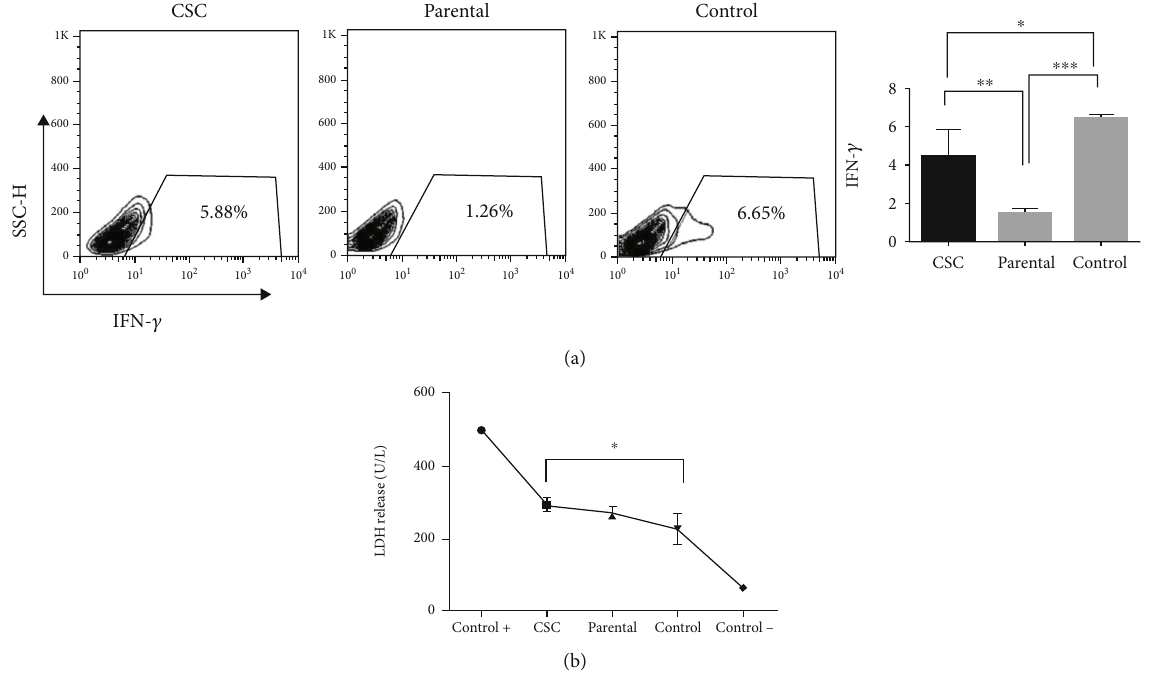
Figure 5: Cytotoxicity of T cells after exposure to gastrospheres and parental cell-derived conditioned media. (a) IFN- γ levels in PBMCs after exposure to gastrospheres or parental cell-derived conditioned media. (b) LDH release of MKN-45 cells (target) in culture with gastrospheres or parental conditioned media induced lymphocytes (e ff ector). CSC: gastrospheres. Data are mean ± SD of three independent experiments. ∗ P < 0 : 05 , ∗∗ P < 0 : 01 , and ∗∗∗ P < 0 : 001